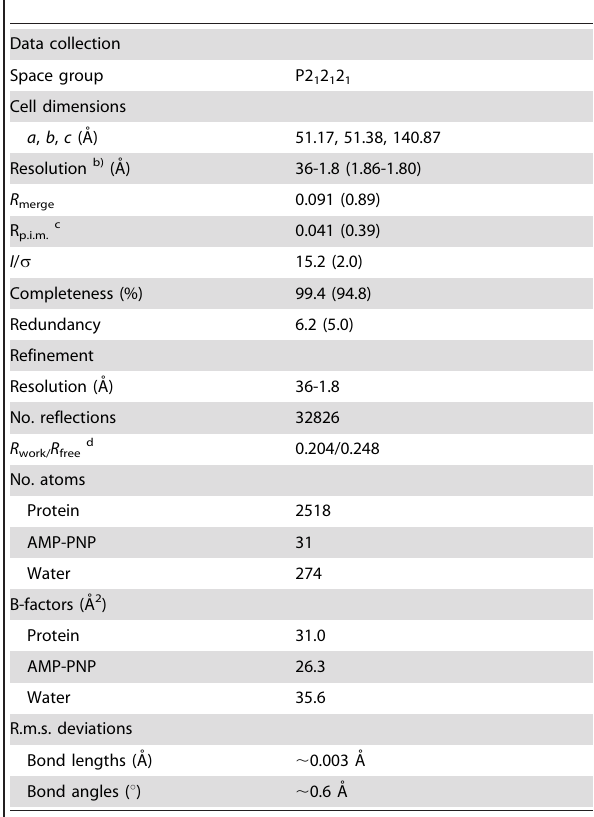
Table 1. X-ray data collection and refinement statistics a)